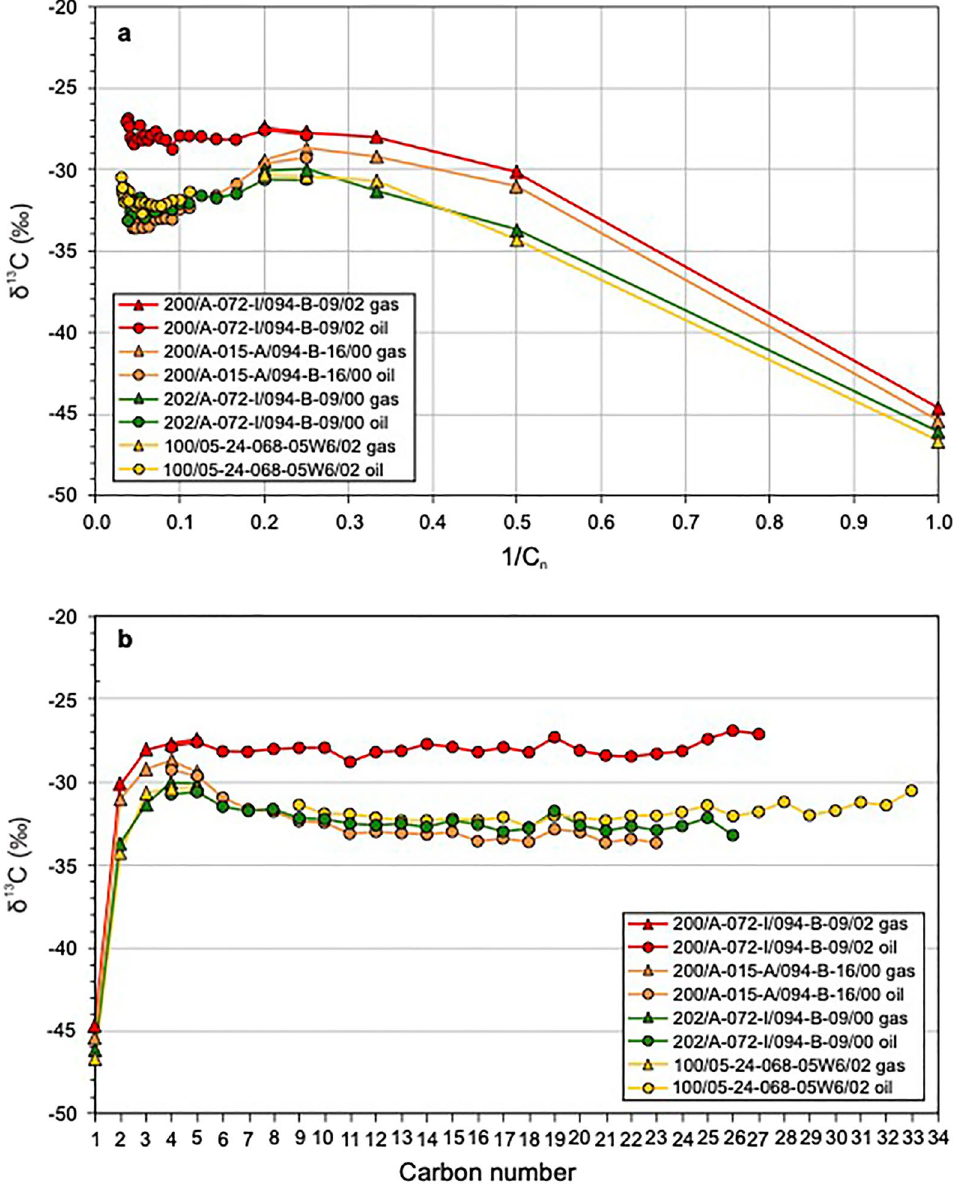
Figure 5. Extended carbon isotope ratio data for four Montney wells with co-produced gas and hydrocarbon liquid data. ( a ) Cross-plot of reciprocal carbon number vs. carbon isotope ratio (Chung plot) 53 . ( b ) Cross-plot of carbon number vs. carbon isotope ratio. Red, orange and green lines indicate wells from the North Montney area. Yellow line indicates a well from the Gold Creek area. Triangles indicate gas samples. Circles indicate hydrocarbon liquid samples. The isotopic profiles progress from a convex upward (“hump”) signature at low molecular weight to an increasing or nearly flat signature at high molecular weight, and suggest mixing of in-situ oil (C 16+ range) and migrated high-maturity gas-condensate (C 1 –C 15